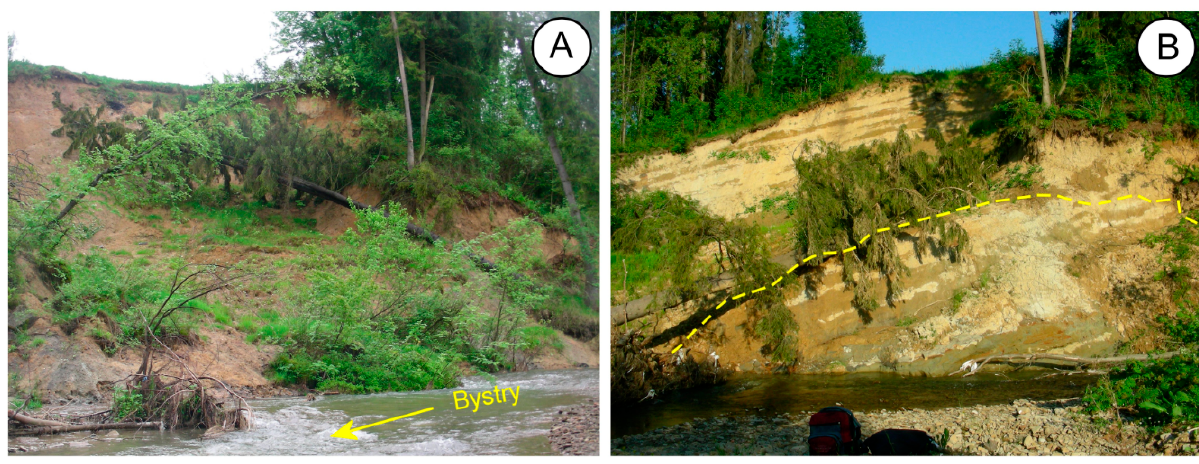
Figure 5. Czerwona Góra landslide (site 3) being undercut by the Bystry, ( A )—Landslide tongue in 2015, ( B )—eroded colluvium in the rejuvenated part of the landslide in